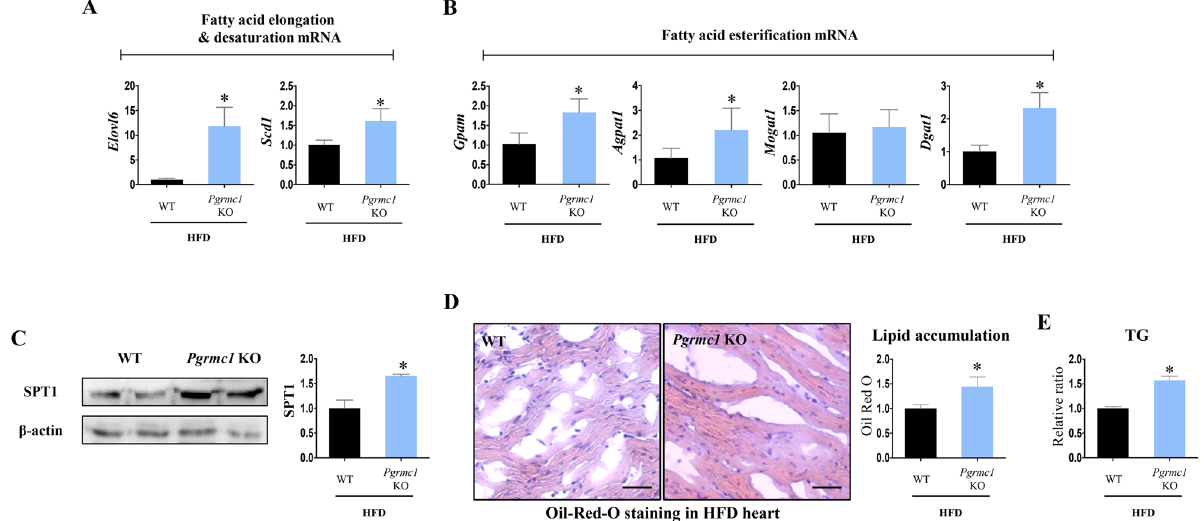
Figure 4. HFD Pgrmc1 KO mice present high cardiac lipid accumulation. ( A ) mRNA expression of fatty acid elongation and desaturation genes in hearts of HFD WT and Pgrmc1 KO mice. Rplp0 was used for an internal control. ( B ) mRNA expression of fatty acid esterification and desaturation genes in hearts of HFD WT and Pgrmc1 KO mice. Rplp0 was used for an internal control. ( C ) Western blot analysis and quantification of SPT1 in hearts of HFD WT and Pgrmc1 KO mice. β-Actin was used for an internal control. ( D ) Oil-Red-O staining and quantification in hearts of HFD WT and Pgrmc1 KO mice (scale bar 25 µm) Positive area was measured by Image J program. Red area was set as positive. ( E ) Relative TG levels in HFD WT and Pgrmc1 KO mice. Values represent means ± SD. *p < 0.05. Student’s t test was performed. Total numbers of mice used for experiment were 10 (HFD WT) and 7 (HFD Pgrmc1